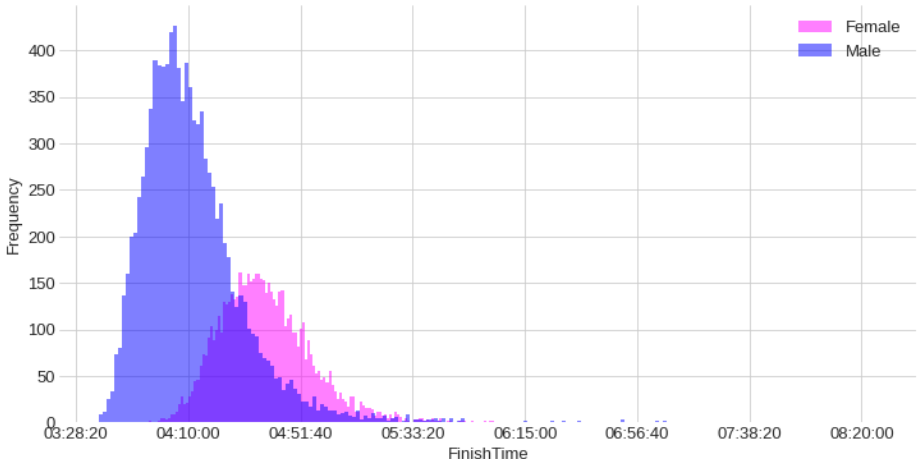
Figure 1. Histograms of the finish time of Ironman ® 70.3 PRO athletes competing between 2004 and 2020.